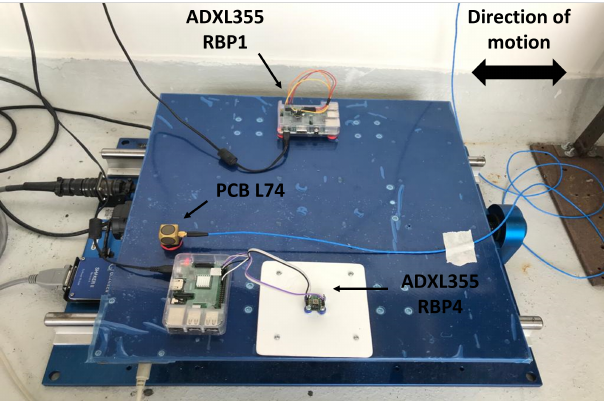
Figure 4. Experimental setup of the frequency chirps on Quanser Shake Table